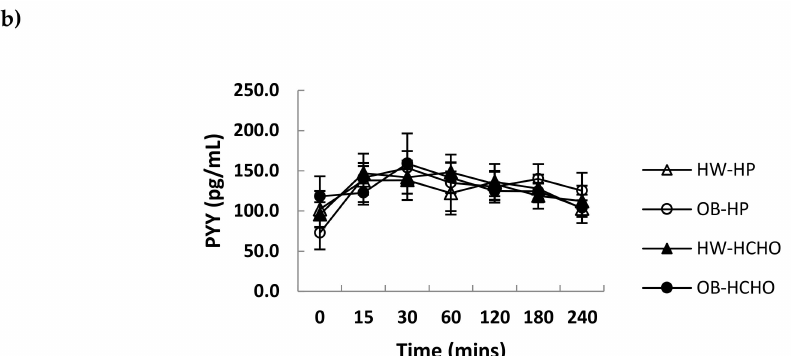
Figure 3. Changes in plasma GLP-1 and PYY concentrations over time after a high-protein (HP) and high-carbohydrate meal (HCHO) in adolescents with obesity (OB) and of healthy weight (HW). ( a ) GLP-1: Effect of time ( p < 0.001) (OB n = 8, HW n = 12); ( b ) PYY (peptide YY): No effect of time or meal, or interaction effects with weight (OB n = 5, HW n = 5) ( p > 0.05 for all values). Data analysed using a mixed between–within-subjects analysis of variance. Data are presented as means (SEM).